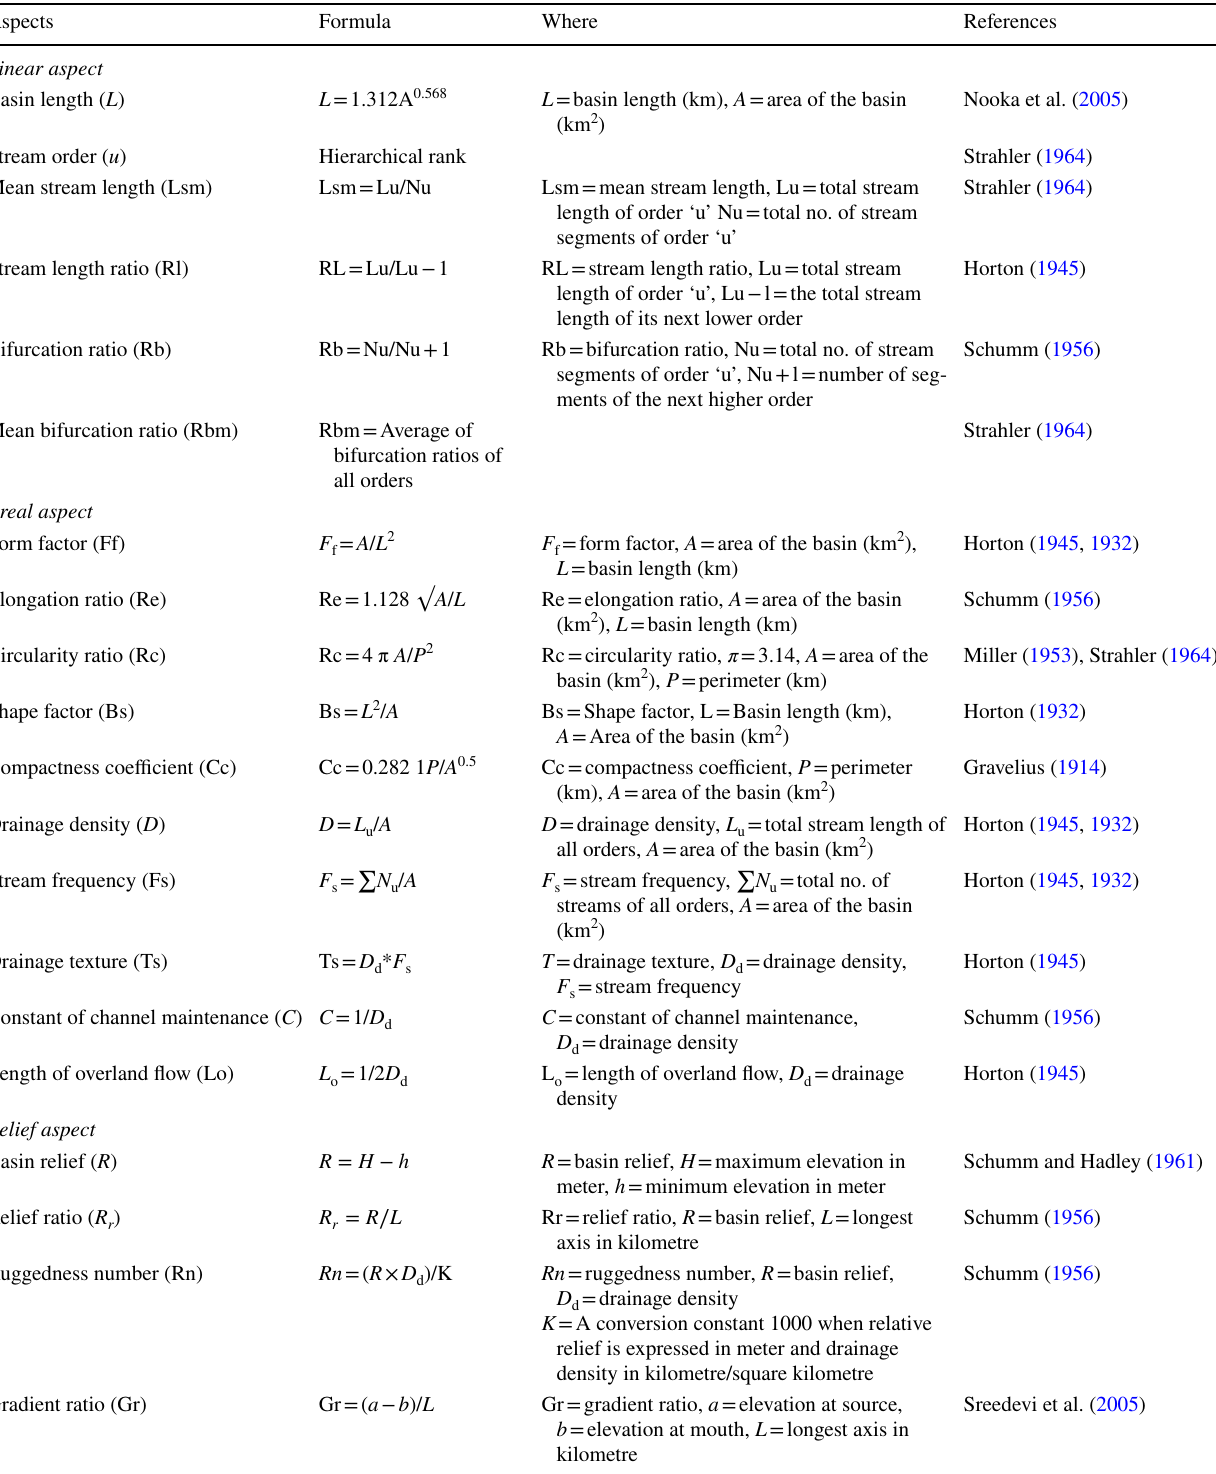
Table 2 Aspect-wise mathematical formulae used based on several morphometric parameters Aspects Formula